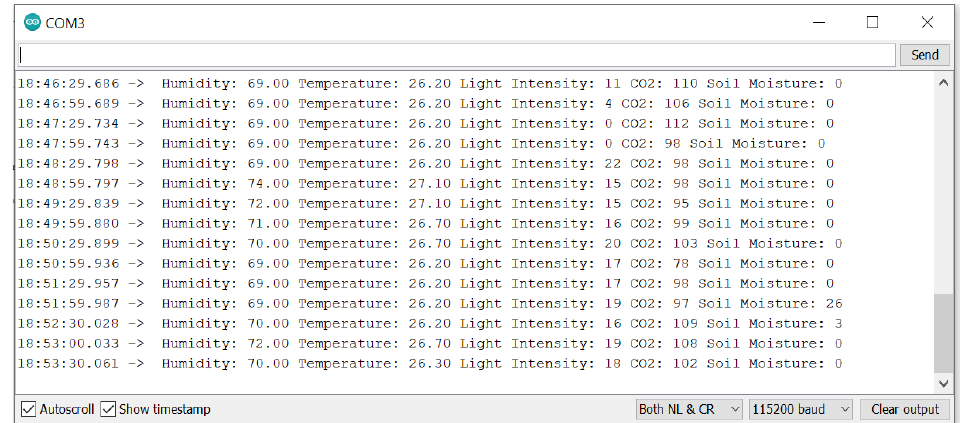
Figure 7. Experimental testbench.